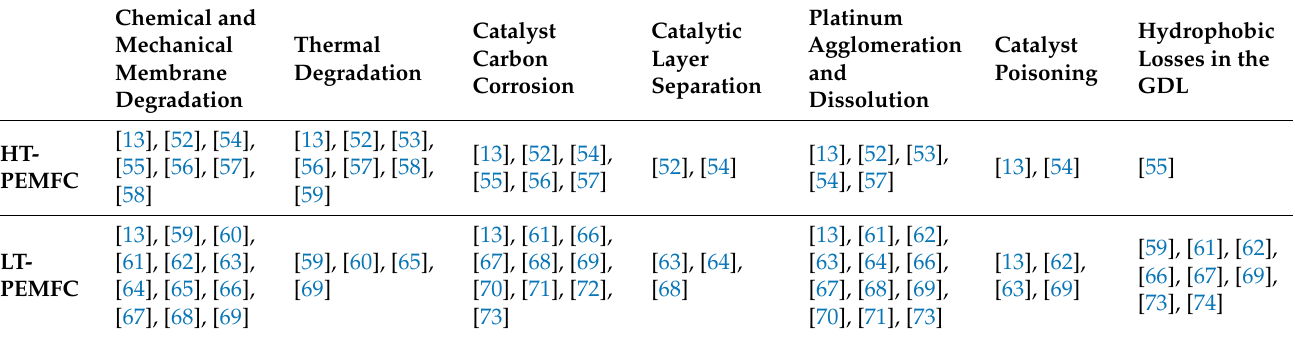
Table 4. PEMFC degradation